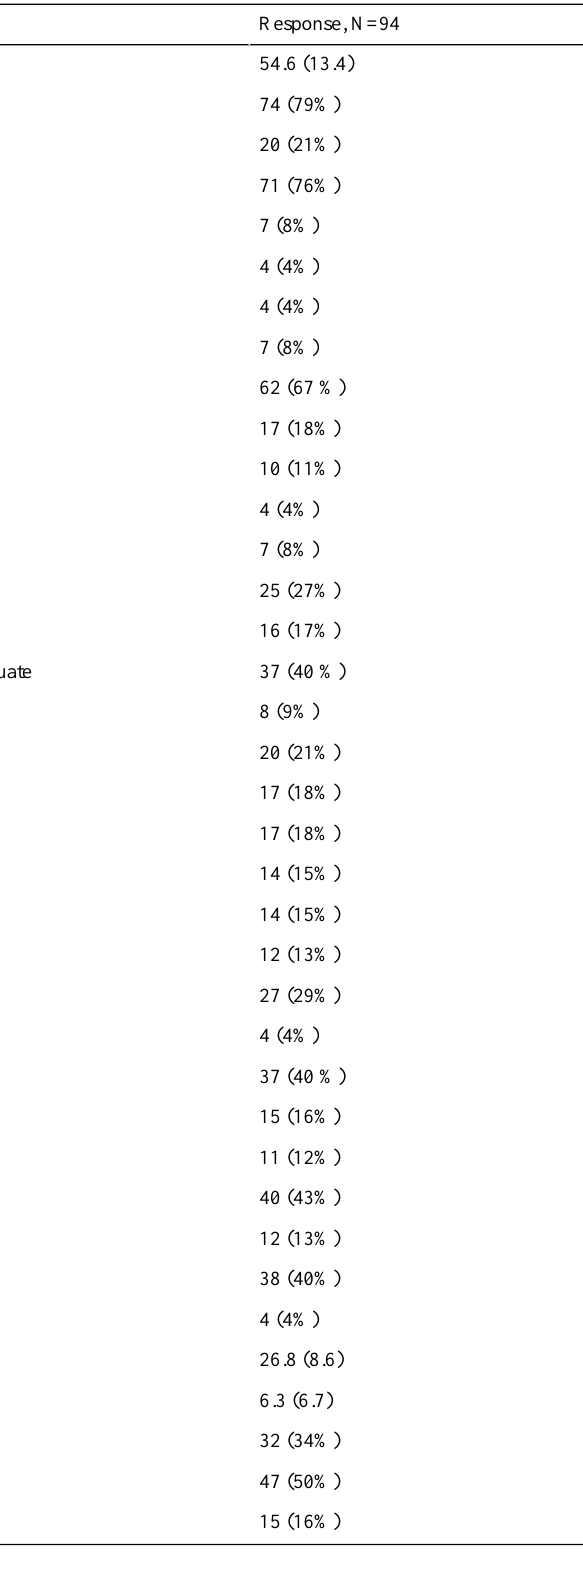
Table 1. Demographic and clinical characteristics of patient participants who returned a completed survey (missing values account for totals less than 94